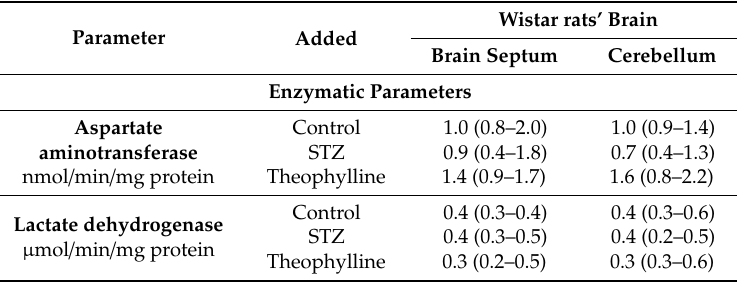
Table 5. Enzymatic activities measured in Wistar rats’